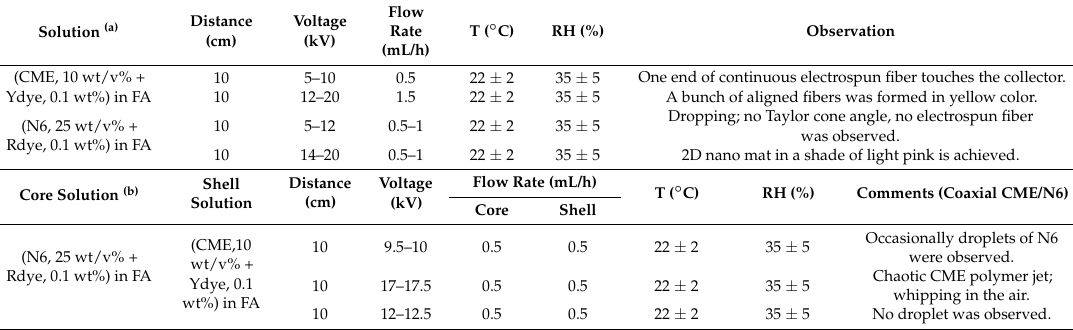
Table 2. The controlled process parameters and the associated